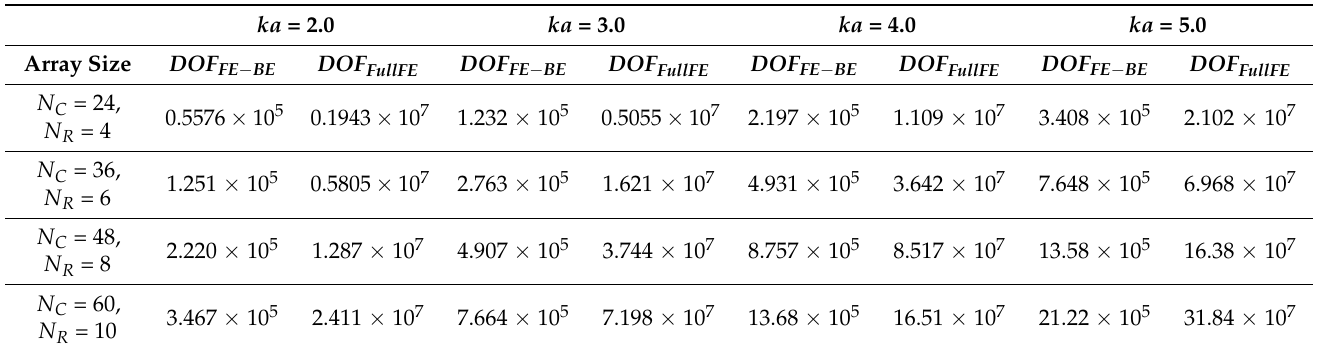
Table 3. Degrees of freedom (DOFs) of the FE-BE coupling model and full FE model. ka = 2.0 ka = 3.0 ka = 4.0 ka =